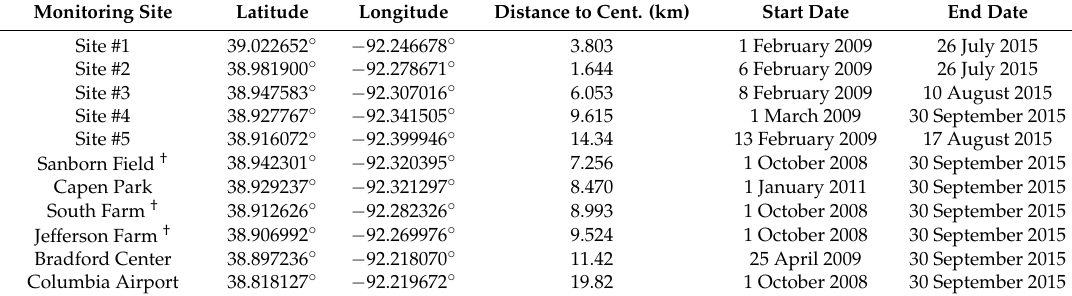
Table 1. Geographic position and date range of the observed data recorded at eleven precipitation monitoring sites during water years 2009 to 2015 in Boone County, Missouri, USA. Distance to Cent. is the distance in kilometers to the centroid of the Hinkson Creek watershed.